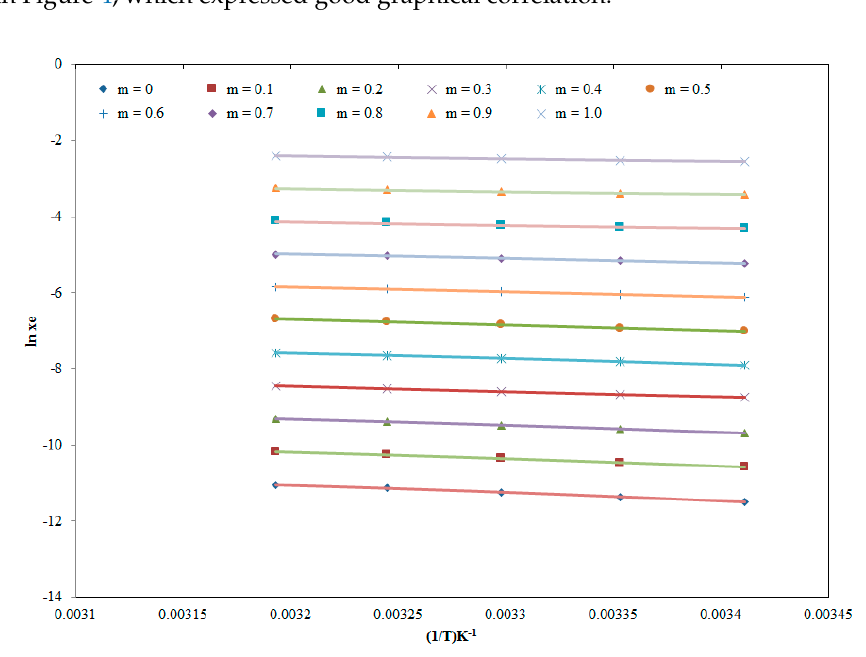
Figure 4. Correlation of experimental solubility values of PPN with “Apelblat model” in different “THP + water” mixtures at “ T = 298.2-318.2 K”; Apelblat model solubility values of PPN are represented by solid lines, and experimental solubility values of PPN are represented by the symbols.